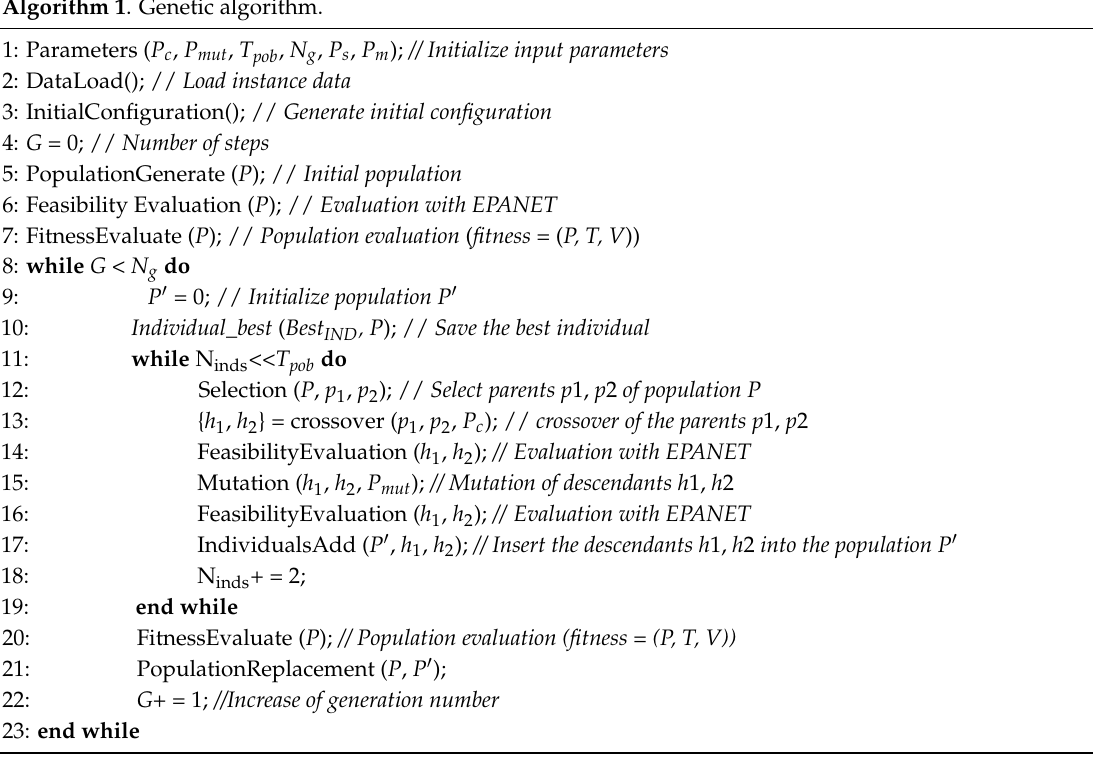
Algorithm 1 . Genetic